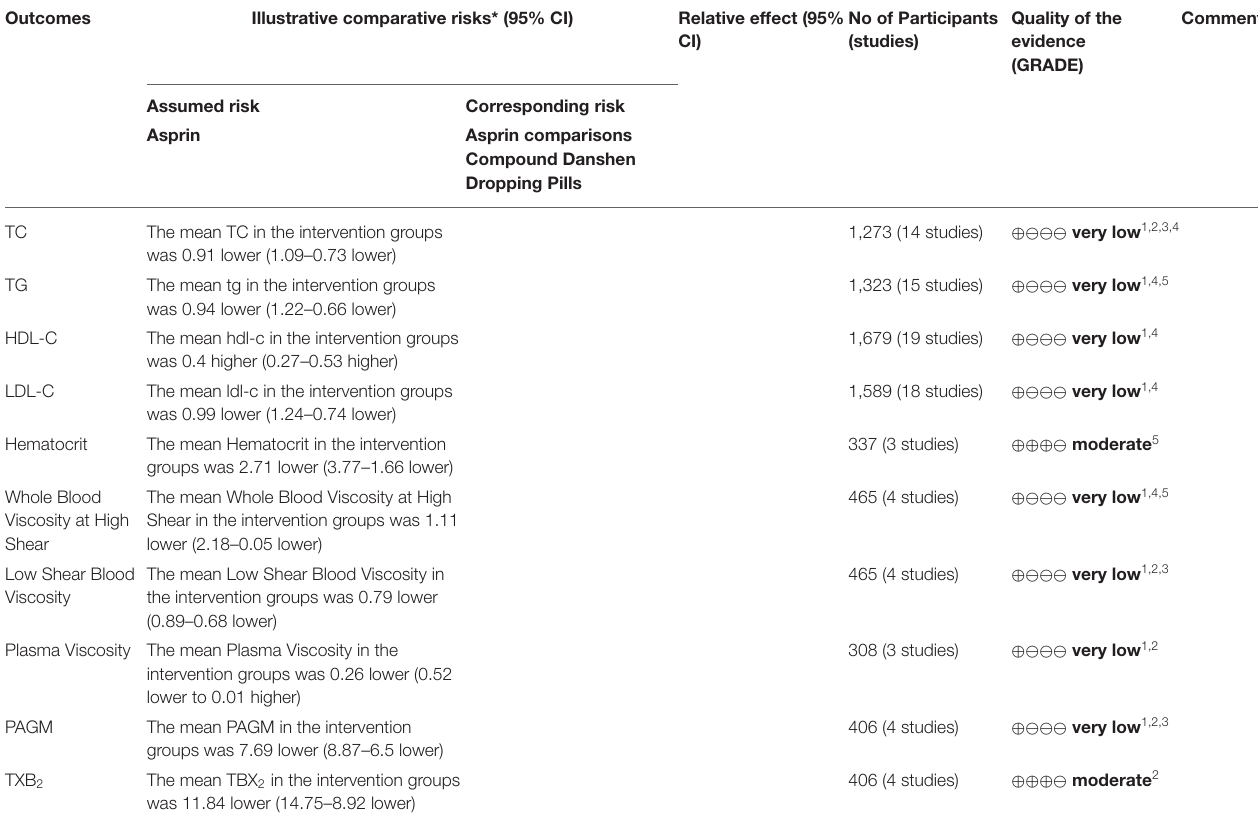
TABLE 2 | GRADE quality of evidence summary table for the comparisons of Fufangdanshen Dripping combined with Aspirin vs. Aspirin for CHD.